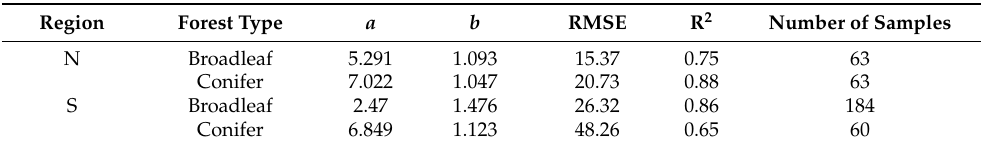
Table 1. Allometric model parameters of different forest types in different geographical regions. AGB = a · H b , where AGB is the plot aboveground biomass (Mg/ha), H is the mean height of dominant trees from the emergent layer and the canopy layer in a field plot. a and b are the power-law function